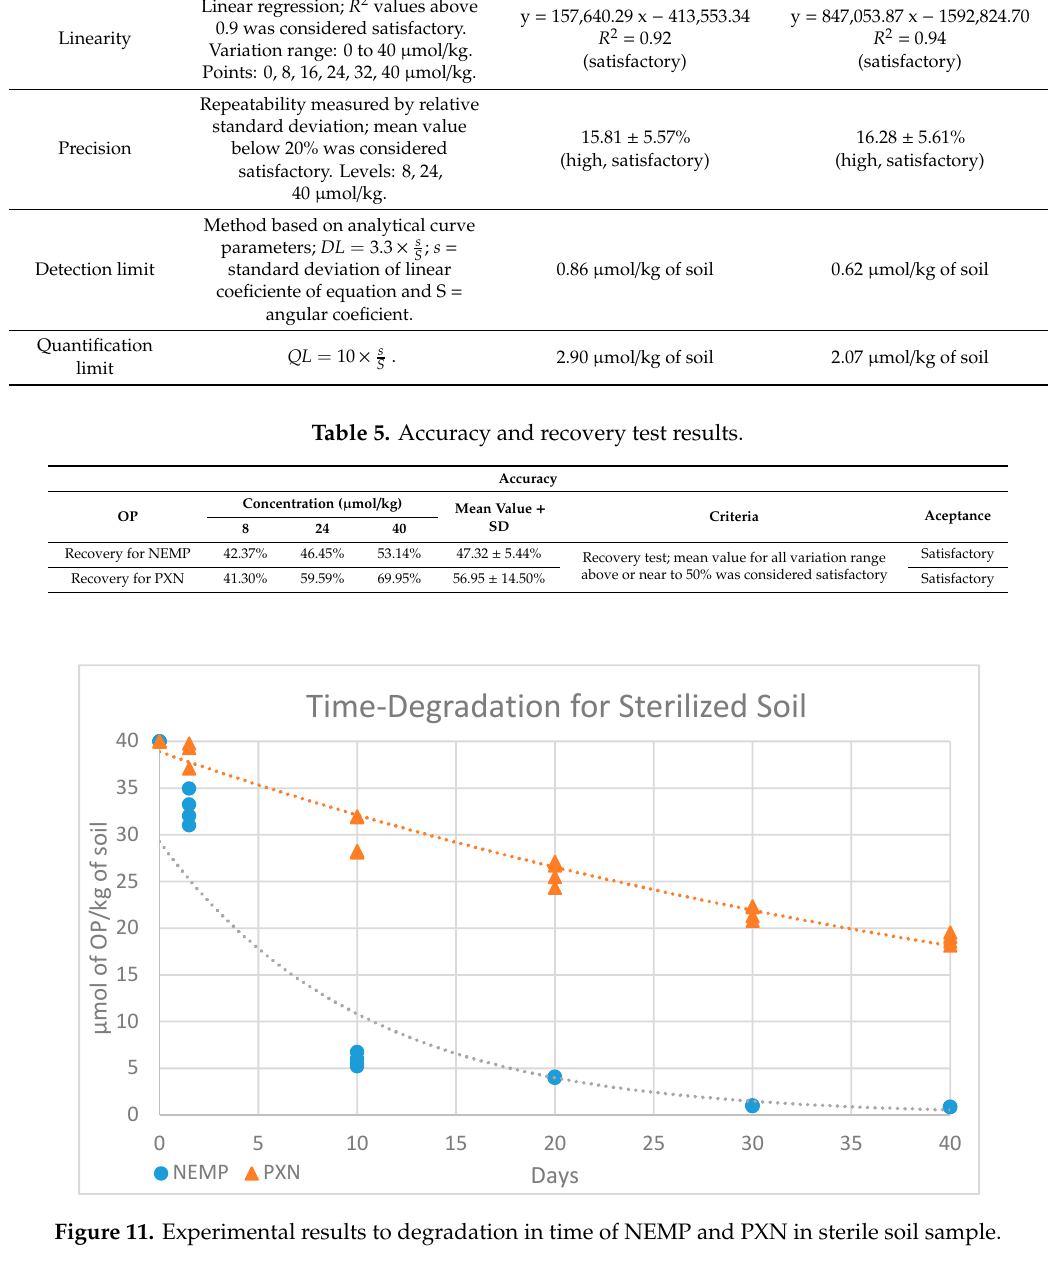
Table 5. Accuracy and recovery test results.